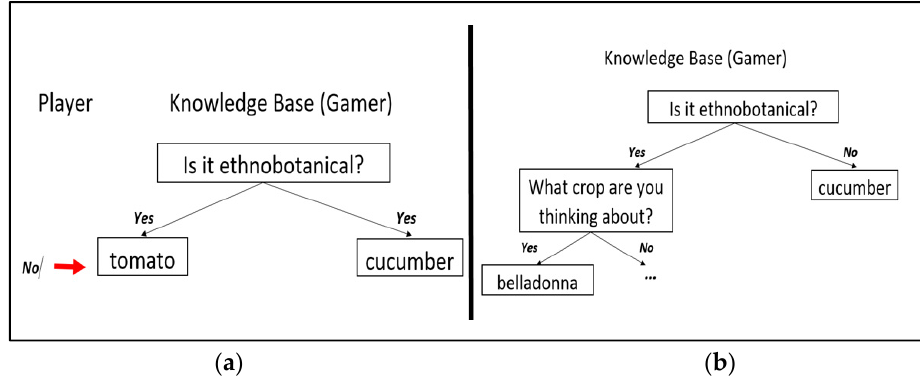
Figure 16. Dynamic construction of the game tree—building a tree ( a ), adding a subtree ( b ).